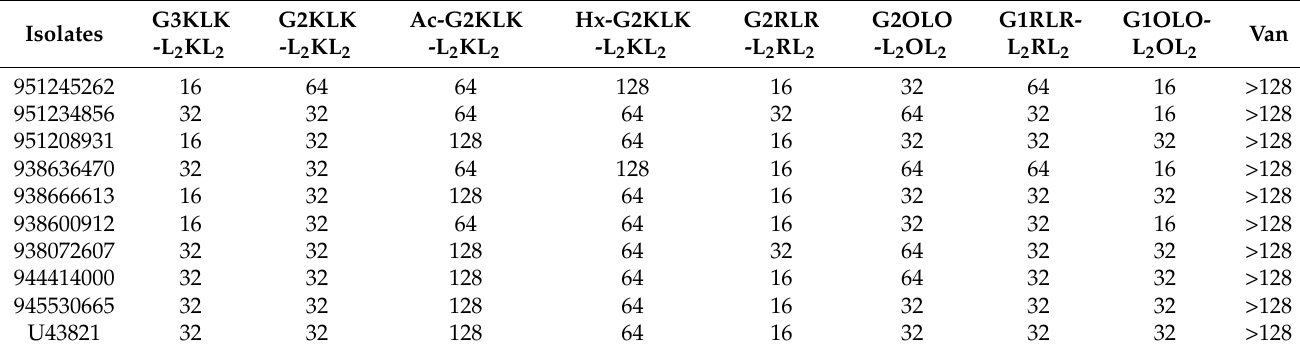
Table 4. MIC ( µ g/mL) values of the SCPDs tested on VRE, E. faecium isolates.